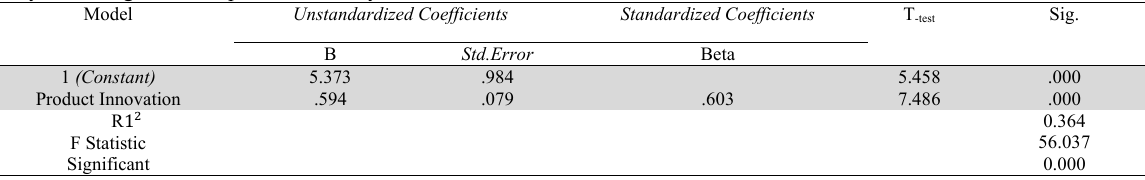
Analysis of Regression Equation Pathway Results